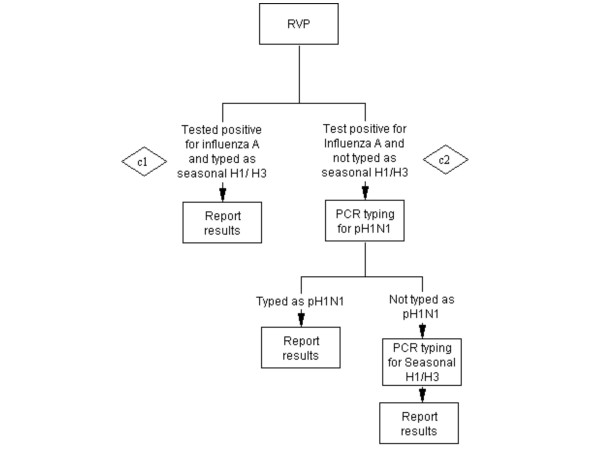
Scenario C - RVP only.